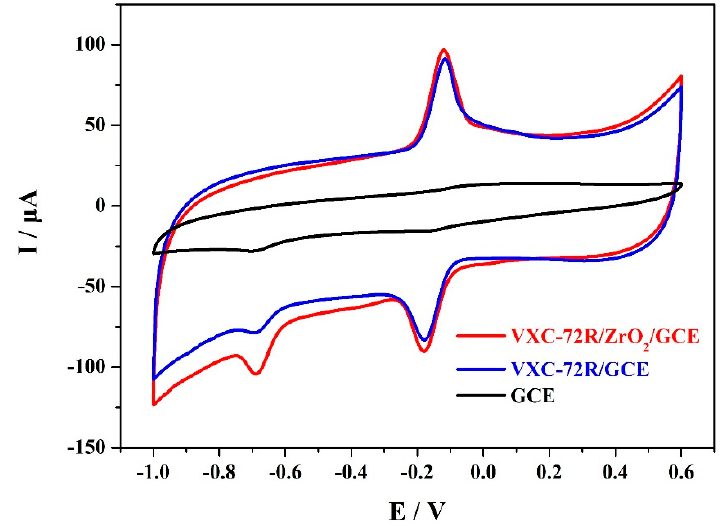
Figure 4. CV curves of 0.1 mM methyl parathion (MP) in phosphate-buffered saline (PBS) (0.1 M, pH 7.0) and the electrochemical sensors based on the undecorated GCEs, VXC-72R/GCEs, and VXC-72R/ZrO 2 /GCEs.